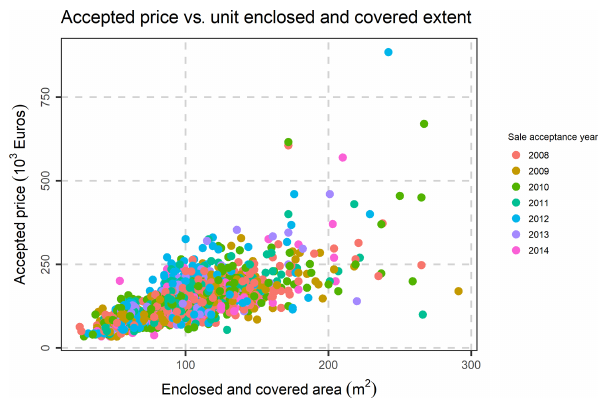
Figure 7. Accepted Price vs. Unit Enclosed and Covered Extend.